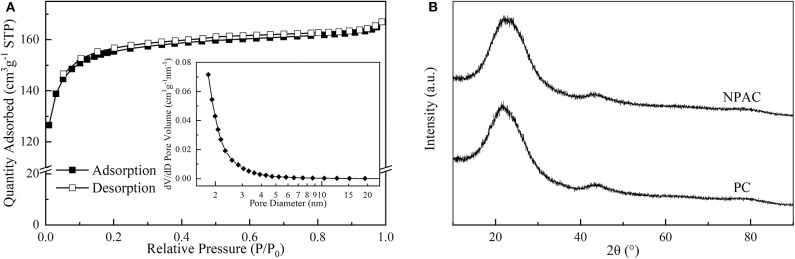
(A) N2 sorption isotherm of NPAC and (B) XRD patterns of NPAC and PC.